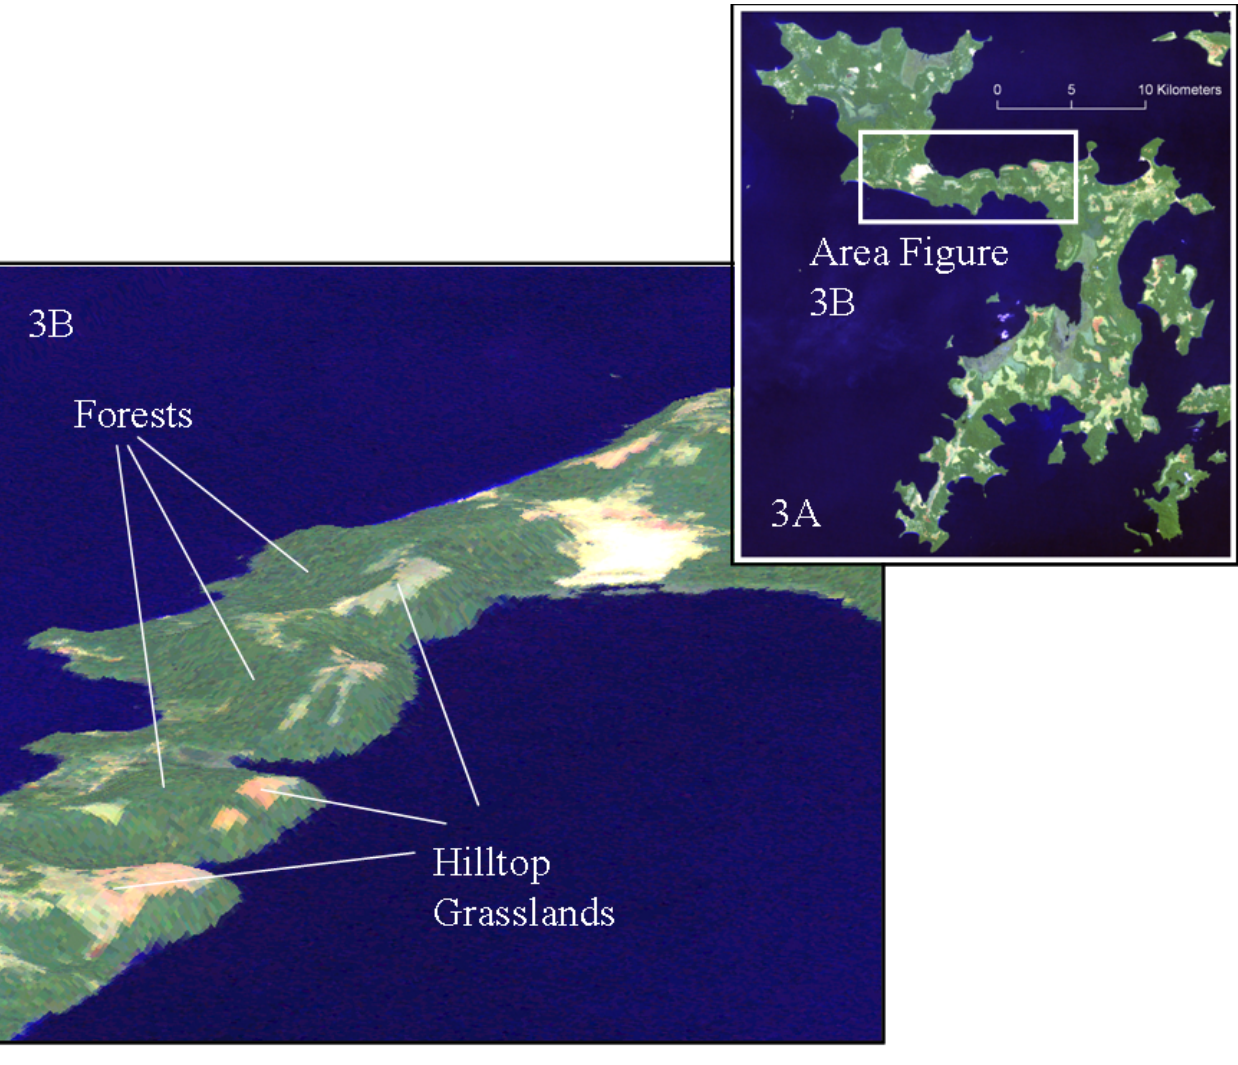
Fig. 3. Multispectral color composite of the sparsely populated Bugala Island, located within 20 km from the study area, and within the same agroecological zone. This composite, when draped over a digital elevation model (DEM), illustrates the natural distribution of forest, greenish colored areas, and grassland, bright, yellowish colored areas, cover in this agroecological zone. This multispectral color composite was generated with a Landsat ETM+ image acquired on 9 July 2002. It is produced by setting band 2, green wavelengths, to drive blue colors, band 5, mid-infrared wavelength, to drive the green colors, and band 7, mid-infrared wavelength, to drive the red colors. The composite was constructed by Sean